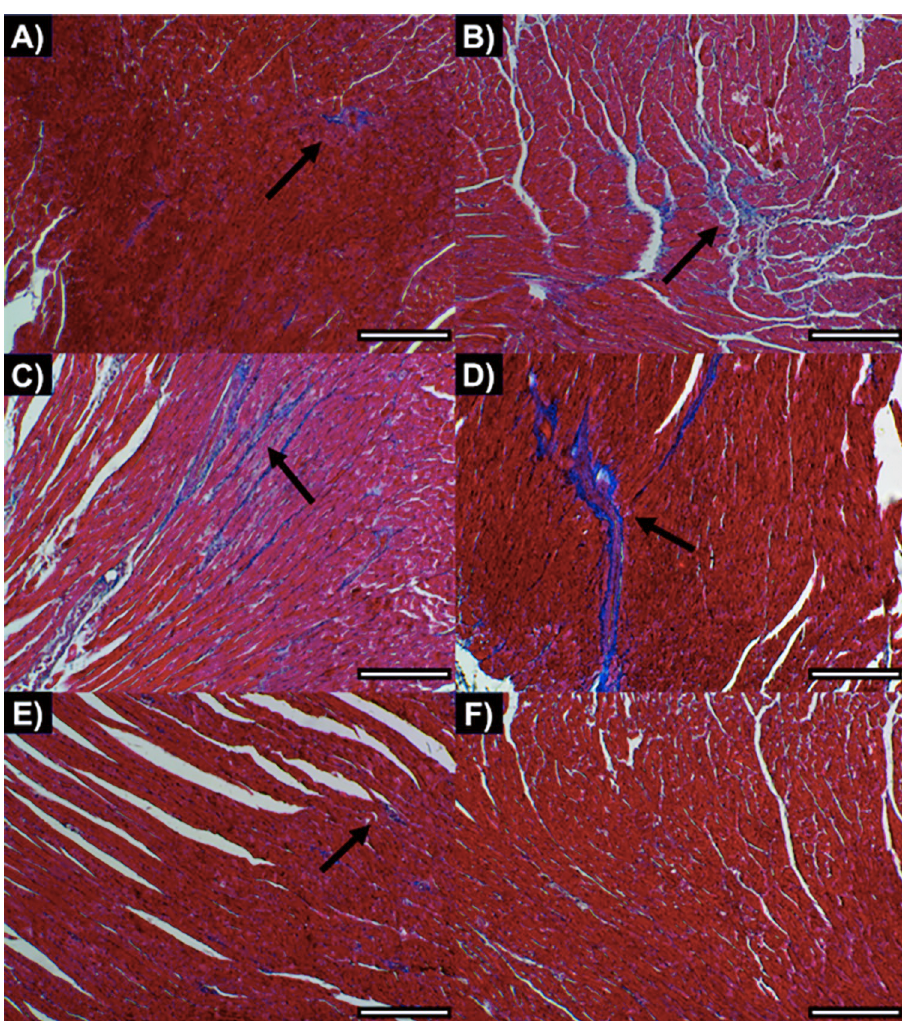
Fig 2. Representative images of Masson´s trichrome stained-cardiac tissue from ( A ) non-infected, ( B ) infected untreated, ( C ) E6020-SE, ( D ) low BNZ, ( E ) vaccine alone and ( F ) low BNZ plus vaccine experimental groups. Five- nine representative photographs were taken from the myocardial region and were acquired at 10X magnification using a microscope adapted with a digital camera. Cell cytoplasm appears in red and collagen fibbers in blue. Black arrows show fibbers of collagen. Scale bar corresponds to 10 μ